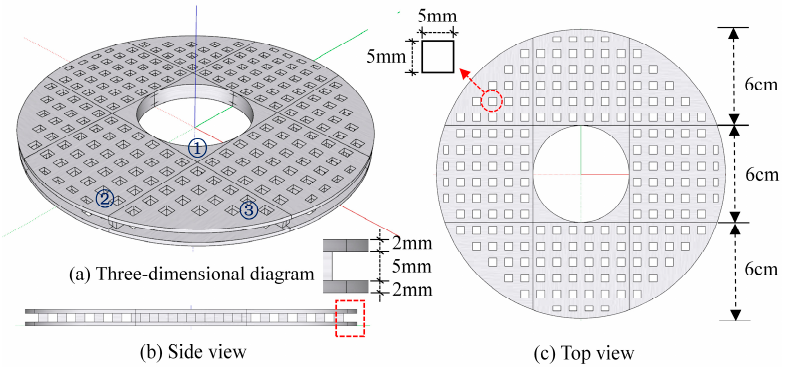
Figure 5. Model design of the permeable collar ( γ = 50%, W/D = 3, T/D = 0.15).